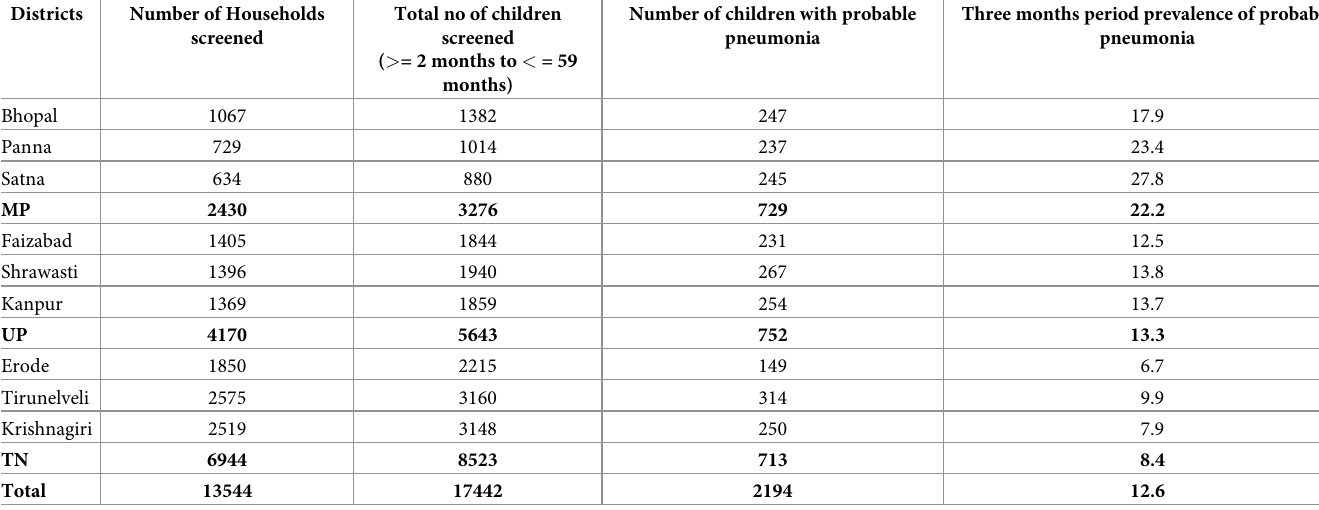
Table 3. Period prevalence of probable